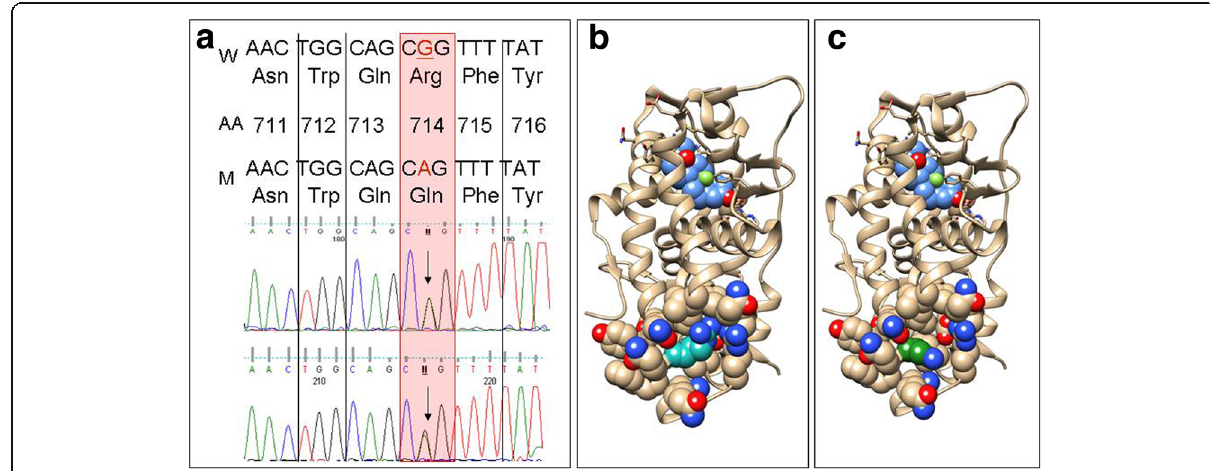
Fig. 1 Sanger sequencing and three dimensional model of the Arg and Gln at postion 714 of the GR gene. Chromatogram showing the heterozygous c.2141G ➔ A mutation of exon 8 of the GR gene in the index patient and her clinically unaffected sister (panel a ); Arginine at position 714 sits on the surface of the domain. The amino acid change from arginine to glutamine may disturb the structure and charge distribution. The GR ligand binding domain coordinates are from PDB structure 4UDC. The domain backbone represented as ribbon. The aminoacid 714 and the surrounding residues are represented with sphere and colored CPK. Arginine side change carbon atoms are colored with light sea green (panel b ), while glutamine side change carbon atoms are colored with forest green (panel c